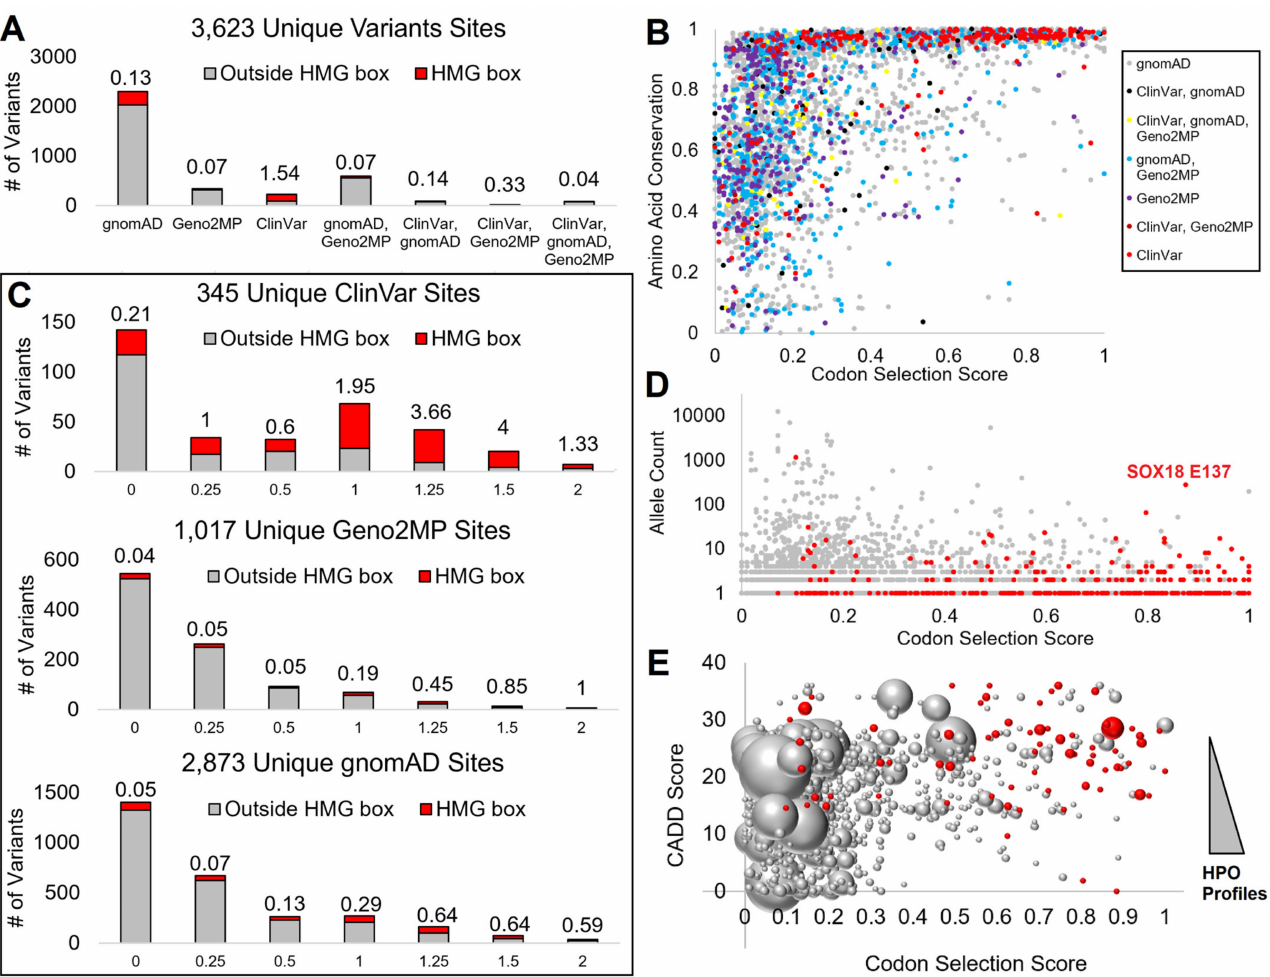
Figure 2. Mapping SOX variants to conserved amino acids. ( A ) Assessment of each amino acid position and the number of variants at that site from each database. Those within the HMG box are in red and those outside the HMG box are in gray, with the value listed above each showing the ratio of variants within the HMG domain. If a variant, whether with the same or a different change, is found in multiple genomics databases for an amino acid, it is listed under the combination of databases. ( B ) Codon selection score (x-axis) relative to the amino acid conservation (y-axis) for each amino acid, colored as grouped in panel ( A ). ( C ) Codon selection score of unique sites for ClinVar, Geno2MP, and gnomAD, where the higher values indicate codon selection. Red represents variants within the HMG box and gray represents variants outside the HMG box. The number above each is the ratio of HMG to non-HMG variants. ( D ) Codon selection score (x-axis) relative to allele count (y-axis) of gnomAD variants. Those in red are within the HMG box. ( E ) Codon selection score (x-axis) relative to the functional variant CADD score of the highest annotation (y-axis). HMG box variants are in red and the bubble size represents the number of human phenotype profiles